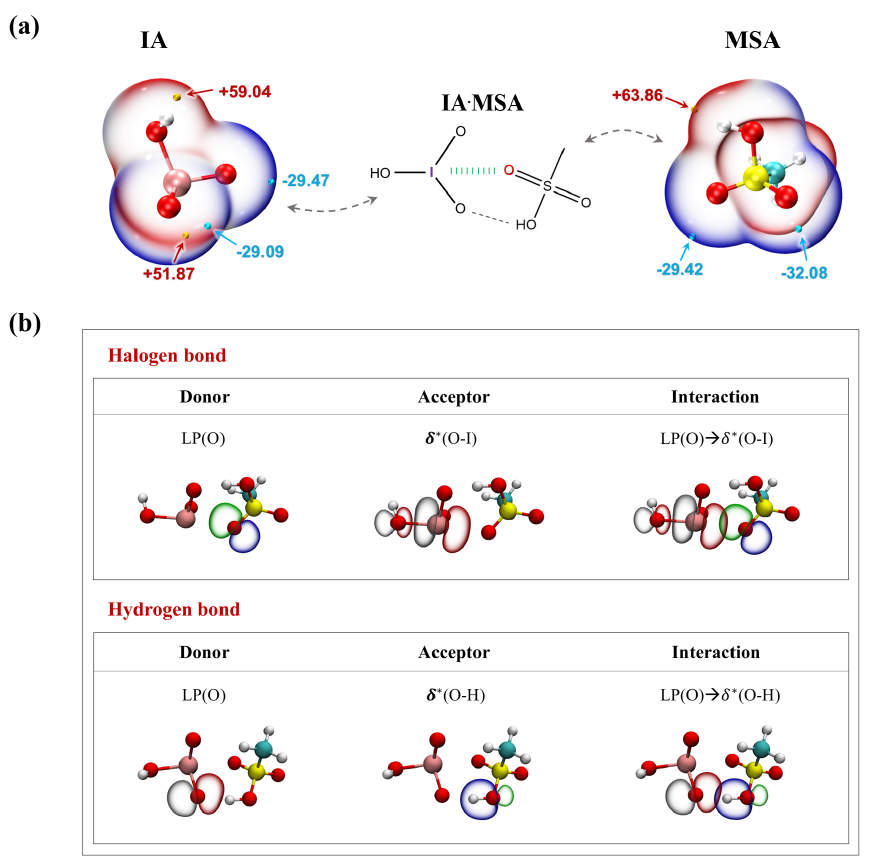
Figure 1. (a) The ESP-mapped molecular vdW (van der Waals) surfaces of iodic acid (IA) and methanesulfonic acid (MSA). The pink, red, yellow, cyan, and white spheres represent I, O, S, C, and H atoms, respectively. The yellow and cyan dots indicate the positions of maximums and minimums of ESP (in kcalmol − 1 ), respectively. (b) The donor–acceptor NBOs involved in the (IA) 1 · (MSA) 1 cluster. LP indicates the lone-pair orbitals, and δ ∗ indicates the antibonding